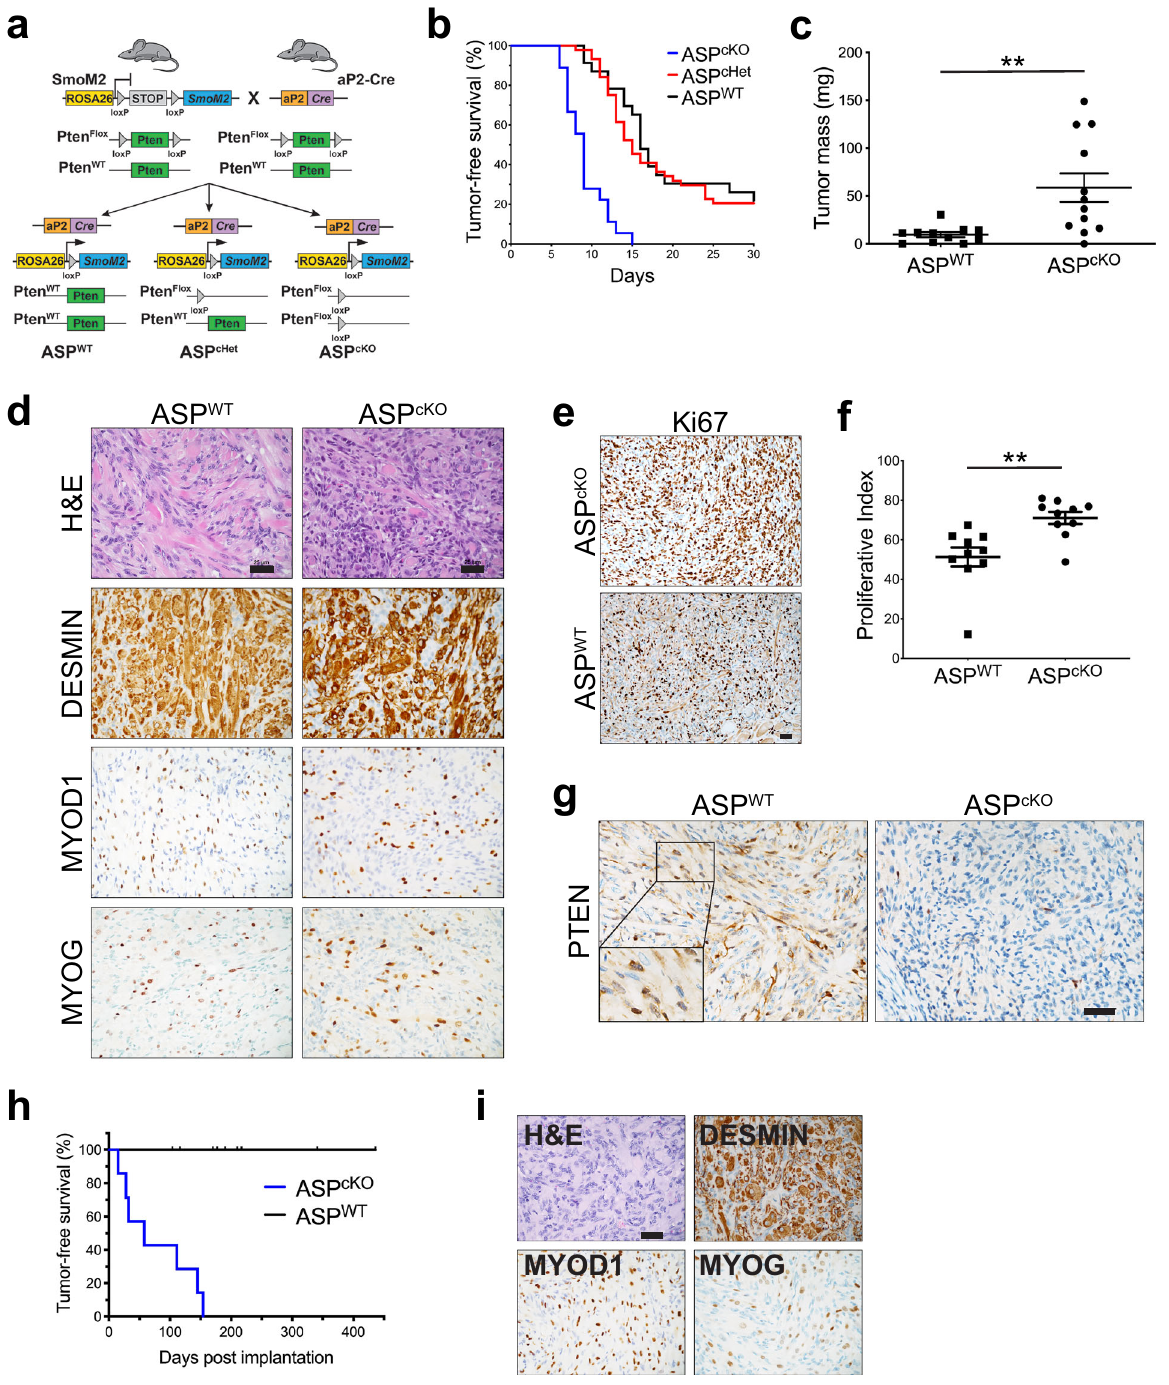
Fig. 1 Pten loss exacerbates aP2-Cre;SmoM2 FN-RMS development. a Breeding strategy to generate ASP WT , ASP cHet , and ASP cKO mice. b Kaplan – Meier tumor-free survival in ASP WT ( n = 23), ASP cHet ( n = 42), and ASP cKO ( n = 18) tumors ( P < 0.0001). c Tumor mass at P12 from ASP WT ( n = 11) and ASP cKO ( n = 12) mice ( P = 0.0052). d Representative histology of ASP WT ( n = 16) and ASP cKO ( n = 16) tumors by H&E and IHC staining for DESMIN, MYOD1, and MYOGENIN (MYOG). Scale bar, 25 μ m. e , f Representative Ki67 IHC ( e ) and quantitation ( f ) in ASP WT ( n = 9) and ASP cKO tumors ( n = 7) tumors (ten random fi elds of view per genotype) ( P = 0.0029). Scale bar, 25 μ m. g Representative PTEN IHC in ASP WT ( n = 3) and ASP cKO ( n = 3) tumors. Scale bar, 25 μ m. h Kaplan – Meier tumor-free survival curve of subcutaneous fl ank allografts of ASP WT ( n = 11) and ASP cKO ( n = 7) tumors ( P < 0.0001). i Representative histology of ASP cKO ( n = 3) allografts by H&E staining and IHC for DESMIN, MYOD1, and MYOG. Scale bar, 25 μ m. All pairwise comparisons determined by unpaired, two-tailed Student ’ s t test. Kaplan – Meier survival curves analyzed with Mantel – Cox log-rank test. ** P < 0.01, mean ± SEM. See also Supplementary Figs. 1 and 2. Source data are provided as a Source Data fi